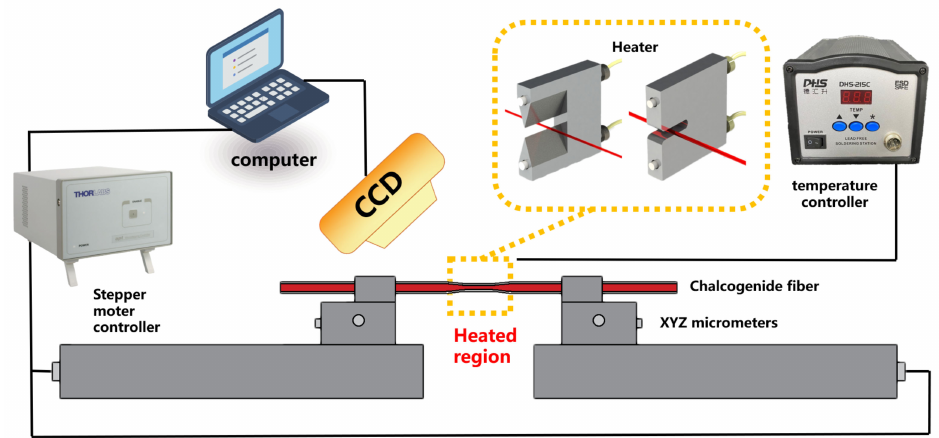
Figure 2. Experimental setup for the chalcogenide fiber